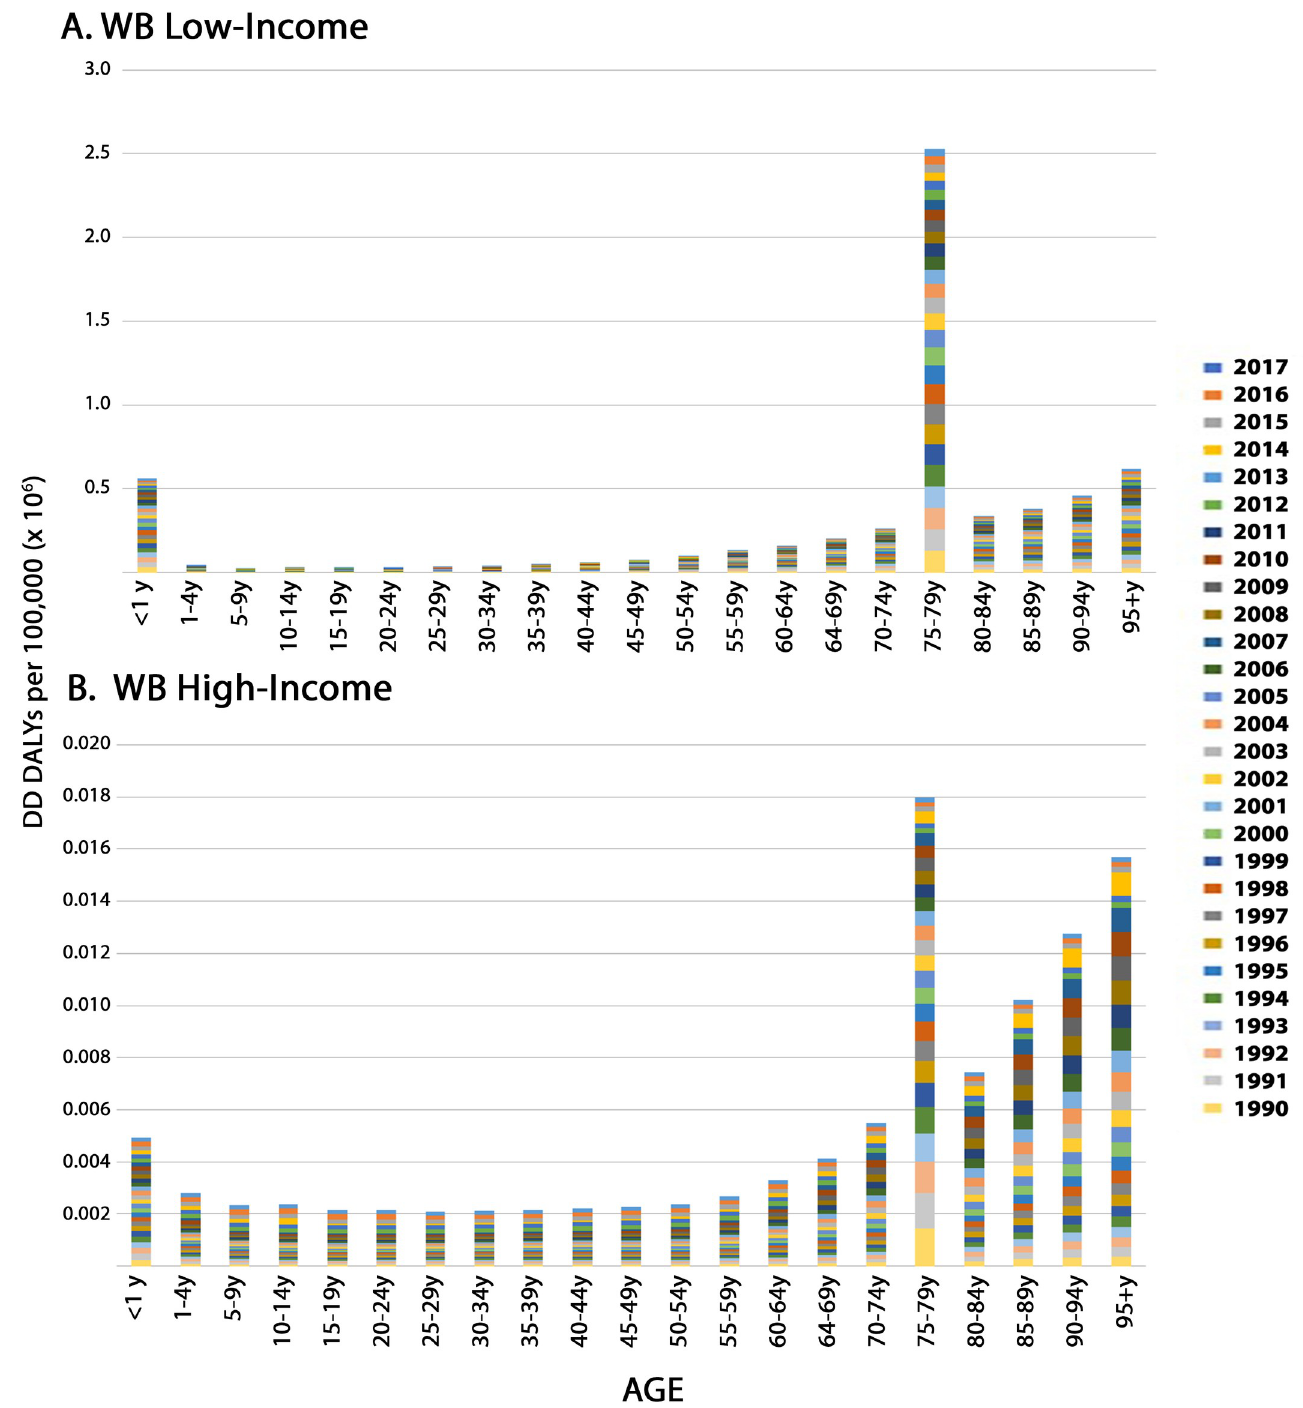
Fig 9. The relationship between age-standardized DD DALY rates per 100,000 and age. Age is given in years (y). The data are plotted for WB low income (A) and WB high-income (B) countries. For each age class (bar), the sum of annual DD DALY rates per 100,000 from 1990–2017 are presented.